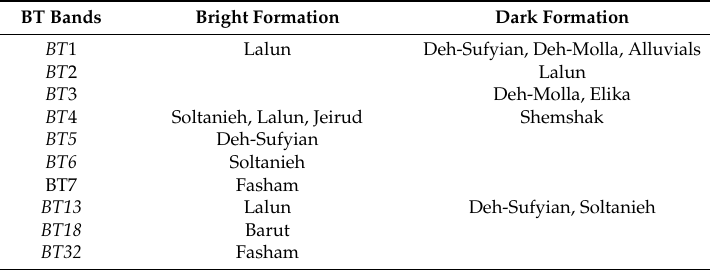
Table 7. Selected input BRMT bands with a specific manifestation (dark or bright pixels) of the sedimentary formations for